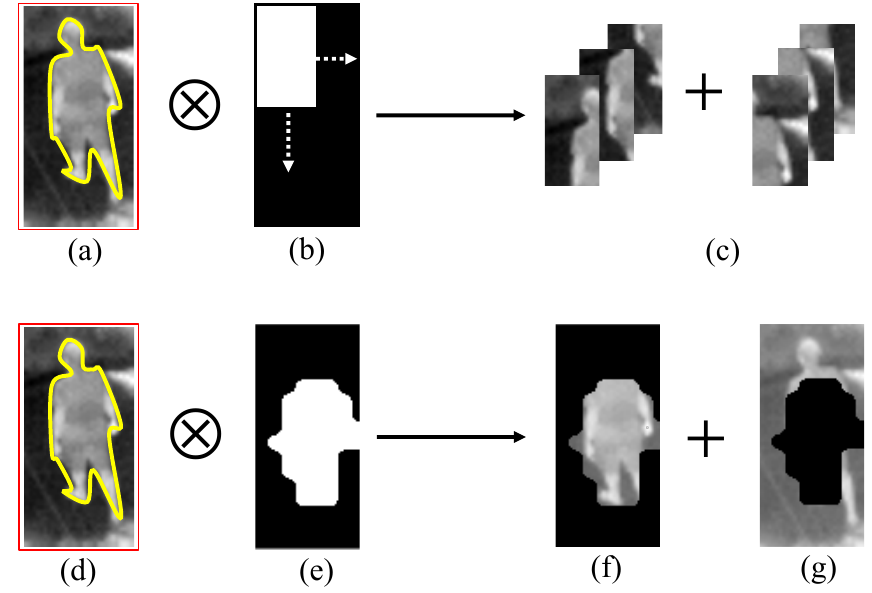
Figure 1. Comparison of the target partition using sliding window and semantic mask template. The upper part of the illustration shows the target partition approach using sliding window, and the lower part shows the target partition approach using semantic mask template: ( a ) tracking target area; ( b ) sliding window; ( c ) target local parts; ( d ) tracking target area; ( e ) semantic mask template; ( f ) reliable target partition; and ( g ) unreliable target partition.